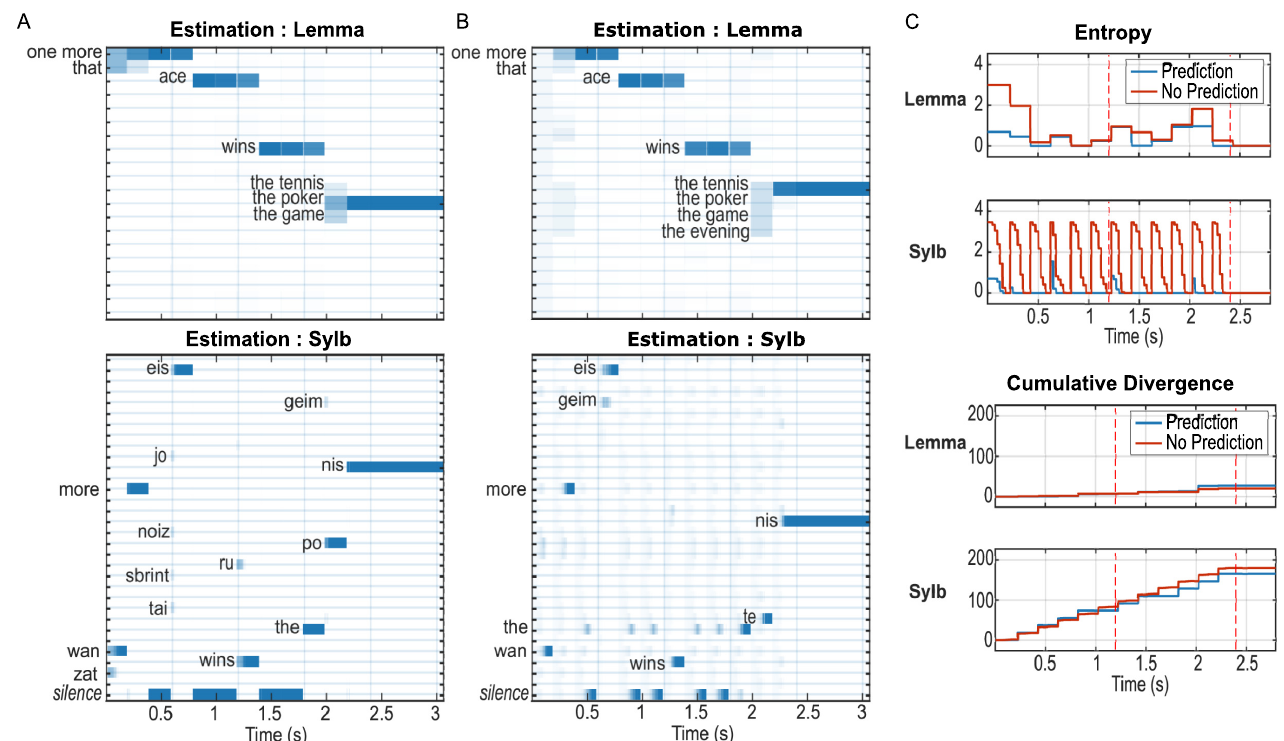
Fig 6. Influence of prediction with lowered peripheral precision. The input sentence, as in Figs 3B and 5A, was “One more ace wins the tennis”. Precision was set to p = exp(0), whereas in the intact model (Figs 4B and 5A), p = exp(16). (A and B) State estimation with and without informative prior. (C and D) Entropy and divergence in the two conditions. ( A) With informative prediction, the result is similar to that in Fig 2A, except that (1) for the last lemma input, the model relied on the prediction, biased towards “the poker”, and made the wrong inference; and (2) for the starting syllable in each lemma, the model took several spectral vectors to converge as indicated by the lighter blue bars. ( B) Without prediction, the model took longer to infer each syllable compared to A, but the inference was correct. ( C) Upper panels: entropy with informative (blue) or uninformative (red) top-down prediction for lemma and syllable estimates. Without informative prediction, the uncertainty increased at the onset of every syllable instead of only for the syllable with multiple possible candidates (e.g., the syllable after “the” in the last lemma) and also reached higher magnitude as well as longer duration compared to the informative condition. Lower panels: cumulative divergence in the two conditions. The divergence for syllable states was lower with informative prediction, but not for lemma. However, the summed divergence of the two levels is slightly higher with uninformative prediction. Simulated data supporting Fig 6A and 6B can be found in ace_tennis_context1_5_P_pre_0_8.mat and ace_tennis_context1_5_NNP_pre_0_8.mat, respectively. Both simulations were used to plot Fig 6C.